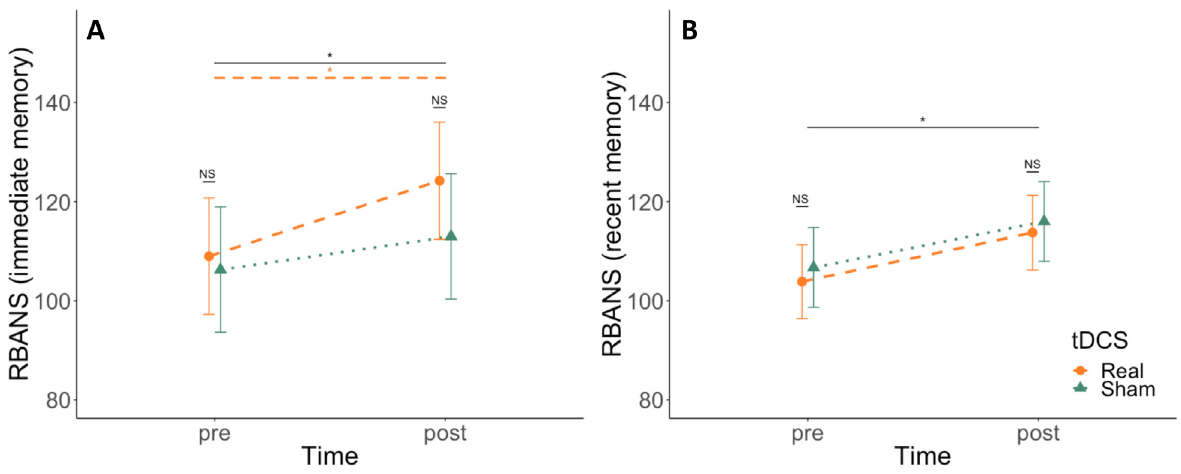
Figure 9. Mean pre- and postscores for encoding on the A . Repeatable Battery for the Assessment of Neuropsychological Status (RBANS) Immediate Memory, and retrieval on the B . RBANS Recent Memory for the sham (dotted, triangles) and real (dashed, circles) group with 95% confidence intervals. Continuous lines indicate main effects, dashed and dotted lines indicate a significant difference between the pre- and postscores of the separate group (real: dashed; sham: dotted) as found by the post-hoc analyses. NS = non-significant; * = p ≤ 0.05; ** = p ≤